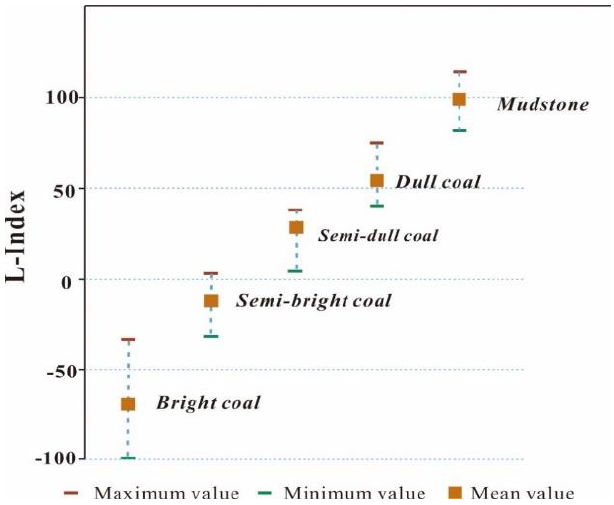
Figure 5. L-Index distribution of different coal macrolithotypes and mudstone.